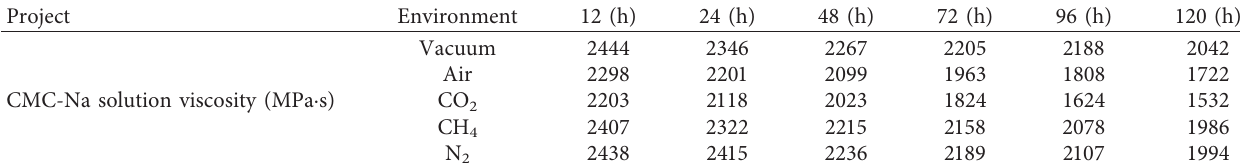
Table 2: Temporal changes in the viscosity of a CMC-Na solution made with groundwater. Project